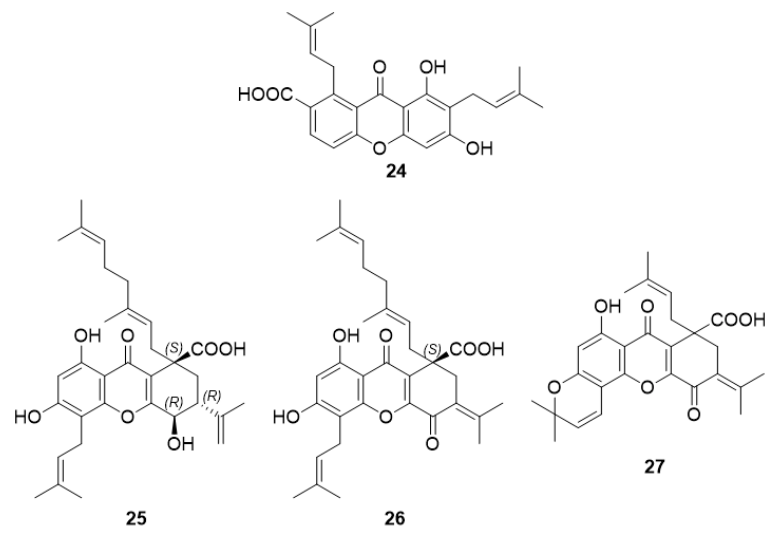
Figure 3. Structures of prenylated carboxyxanthone derivatives ( 24 – 27 ).